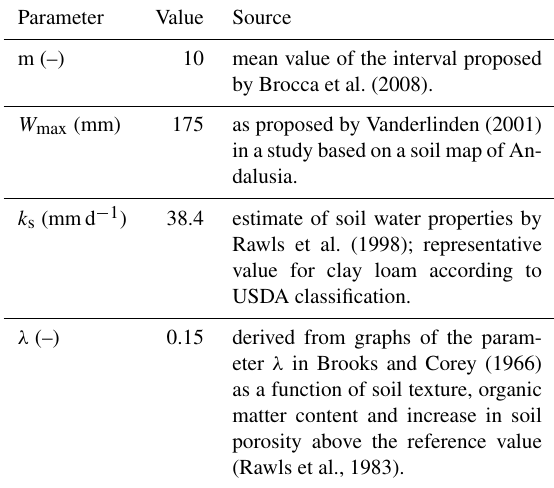
Table 1. Classification of droughts according to SPI and their prob- ability of occurrence following McKee et al. (1993)